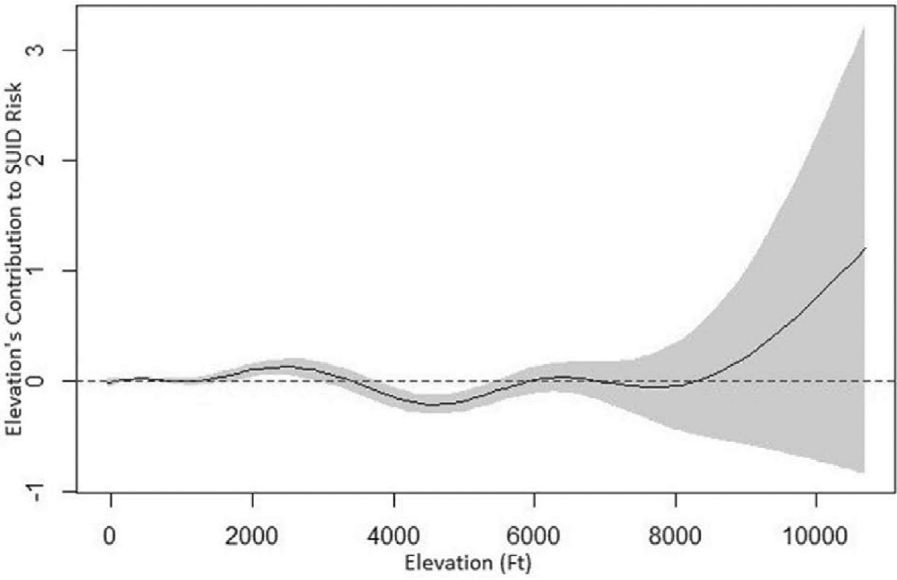
Figure 1. Generalized additive model showing the change in risk of SUID with altitude (solid line with 95% confidence interval). The dashed line is the average risk for the U.S. over the study period